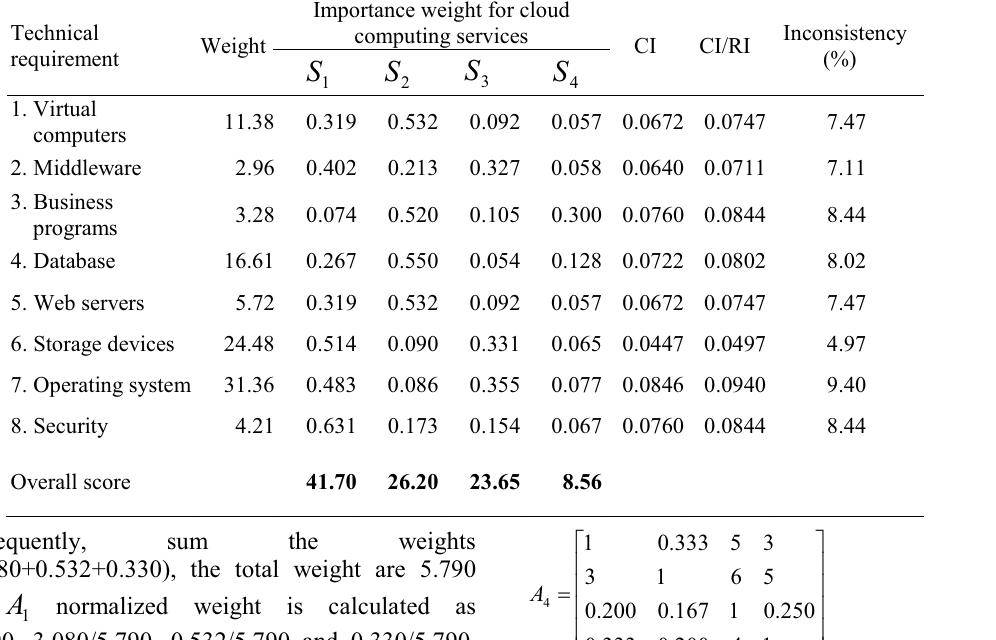
Table 3. Overall score of the cloud computing services